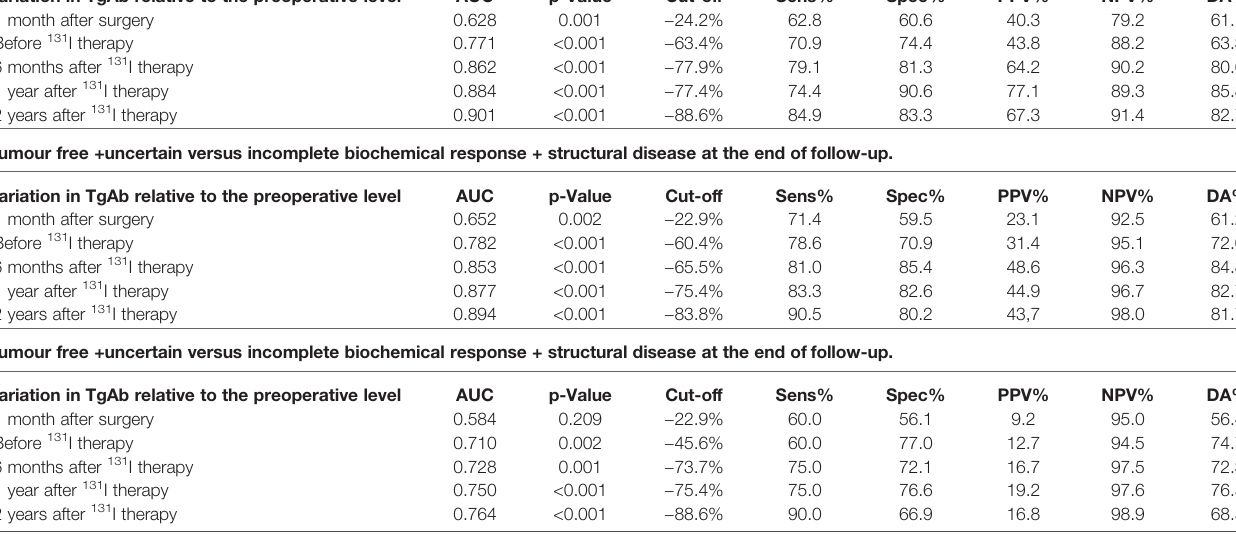
TABLE 4 | Diagnostic bene fi t of variations in TgAb relative to the preoperative levels in predicting the clinical outcome (by ROC analyses). Tumour free versus uncertain + incomplete biochemical response + structural disease at the end of follow-up. Variation in TgAb relative to the preoperative